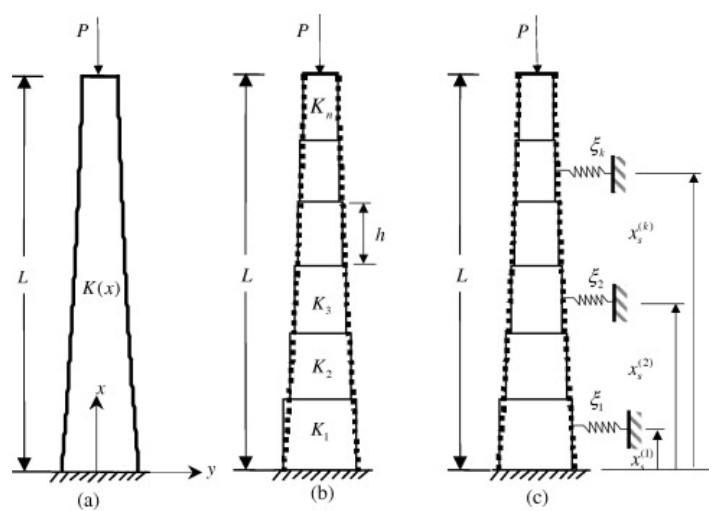
Figure 7. Examples of ( a ) nonuniform and nonhomogeneous axially graded columns, ( b ) piecewise continuous approximated model (of order n ), and ( c ) axially graded column (order n ) with multiple intermediate elastic restraints. Reproduced from [75] with permission from Elsevier ® , license n. 5026040108100.